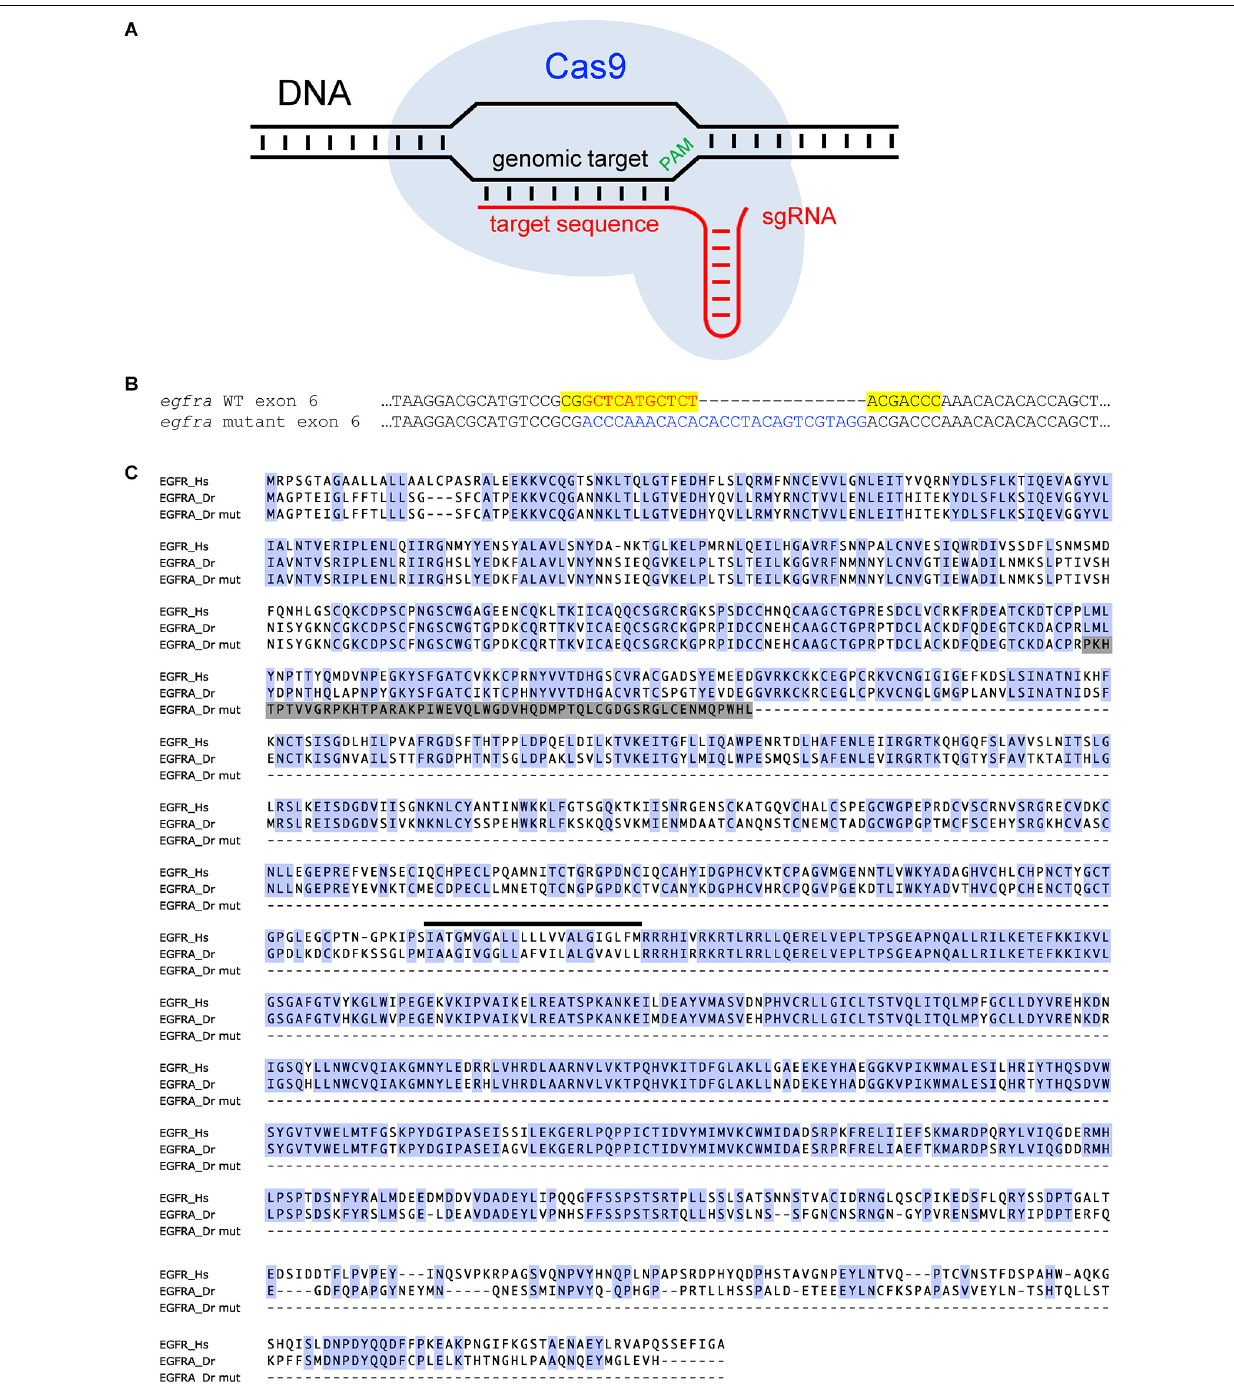
Frontiers in Molecular Neuroscience |